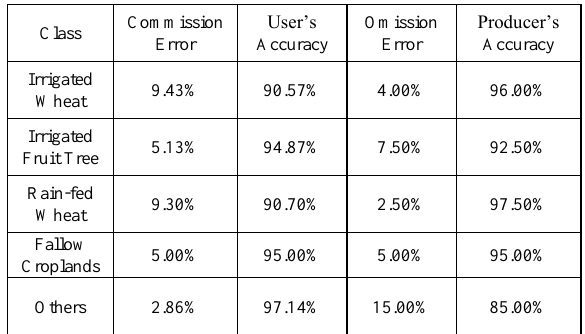
Figure 3. The spatial distribution of croplands during the winter-spring irrigation period of 2018 with 16 m resolution